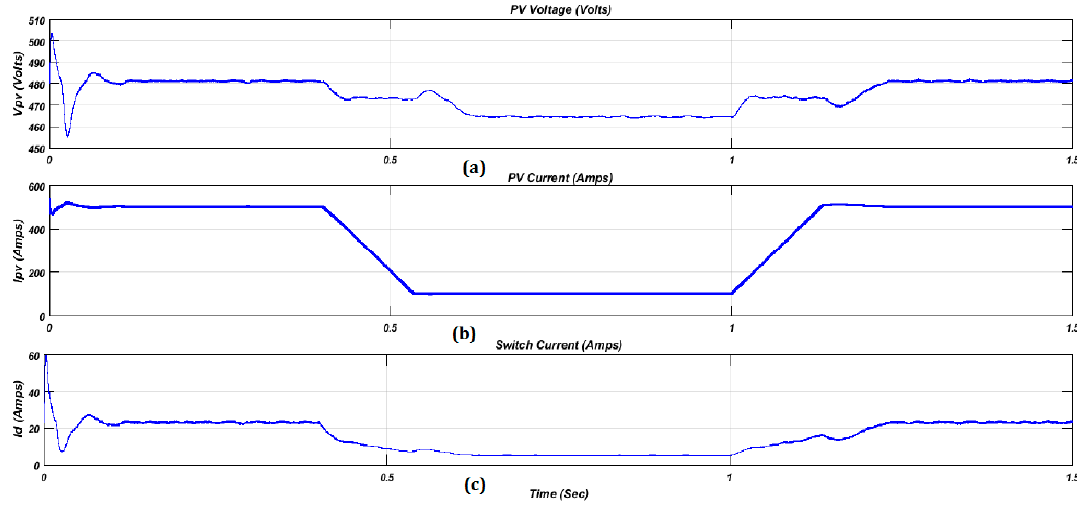
Figure 6. Solar plant results: ( a ) PV voltage, ( b ) PV current, ( c ) switch current.